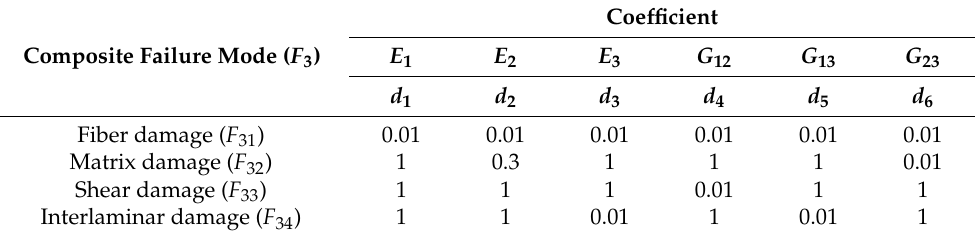
Table 5. Material stiffness degradation coefficients.